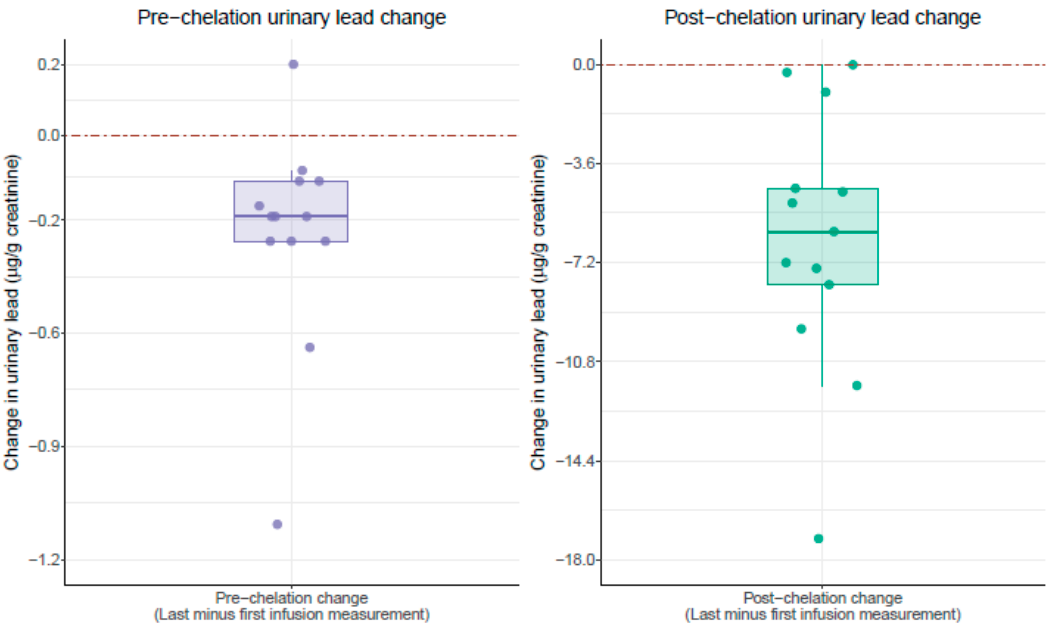
Figure 2. Effect of chelation therapy on patient urinary lead concentrations (µg/g of creatinine). All values are controlled for creatinine concentration. Each dot represents the within-person change in urinary lead concentrations (µg/g of creatinine) comparing urine collected at the last (final) infusion minus urine collected at the first (baseline) infusion for an individual patient. The left panel compares the within-person change in the urinary lead concentrations (µg/g of creatinine) for urine samples collected pre edetate chelation. The right panel compares the within-person change in urinary lead concentrations (µg/g of creatinine) for urine samples collected post edetate chelation. Boxplot upper, middle, and lower hinges correspond to the 25th, 50th, and 75th percentiles, respectively. The red dashed line indicates zero (no change).